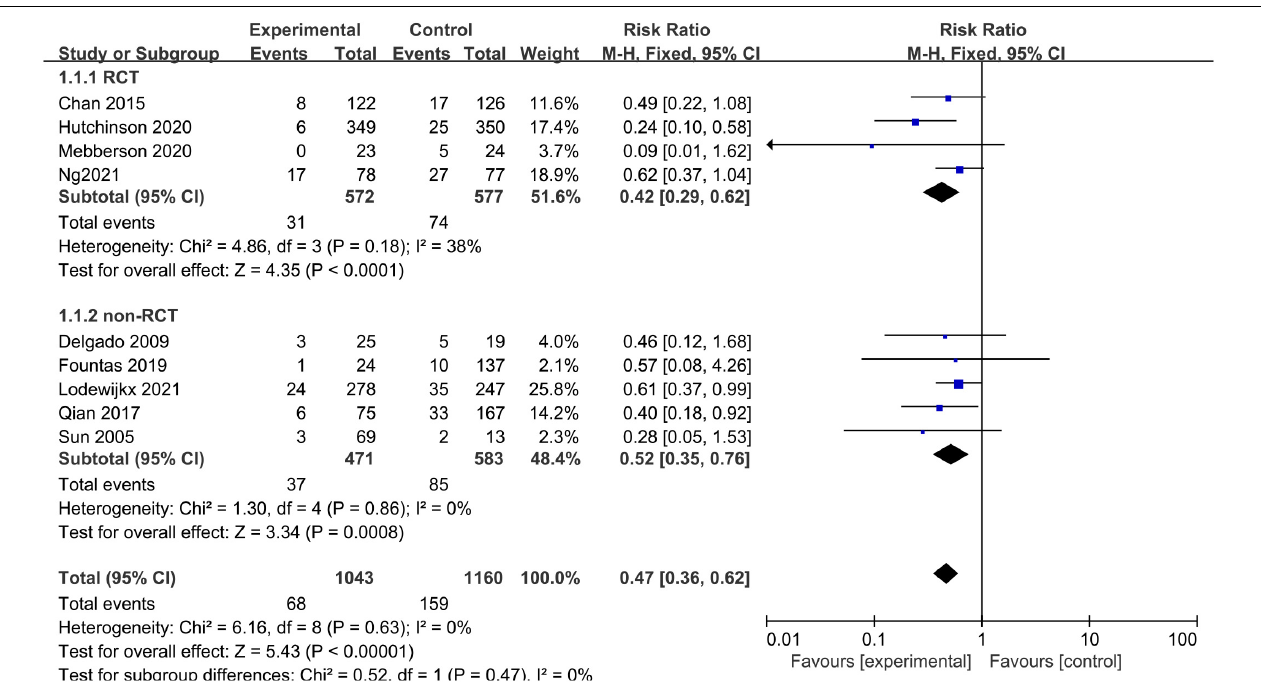
FIGURE 2 | Meta-analysis of adjuvant corticosteroid group compared to the surgery alone group on recurrence rate.